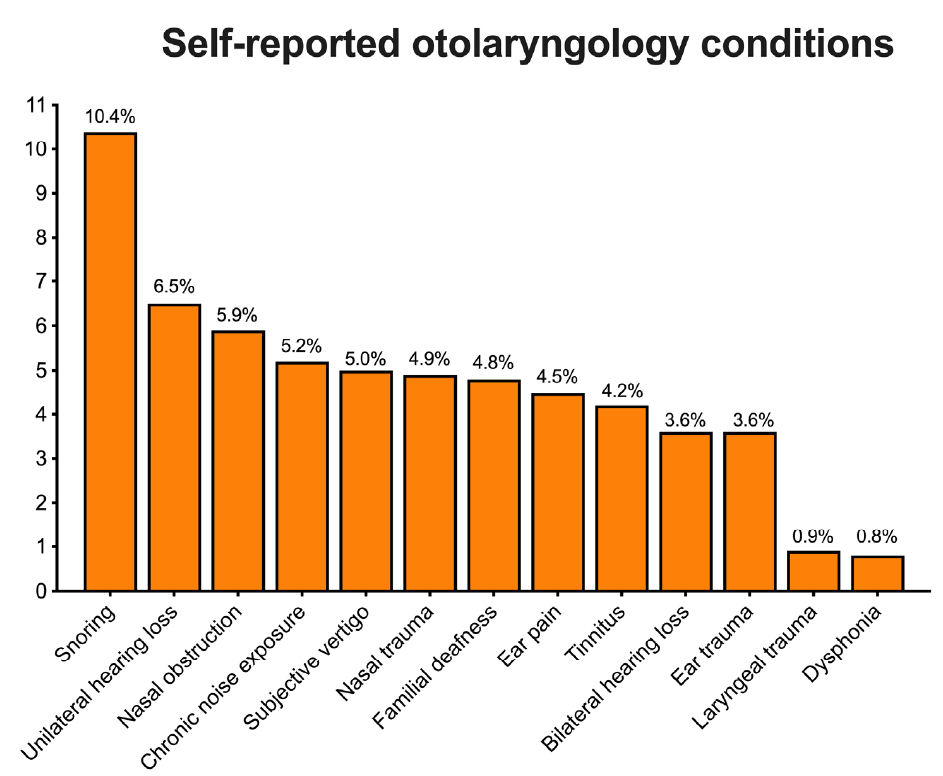
Figure 2. Histogram of otolaryngological conditions and symptoms reported by patients in the operator-administered questionnaire. Data above each column were rounded to the first decimal.